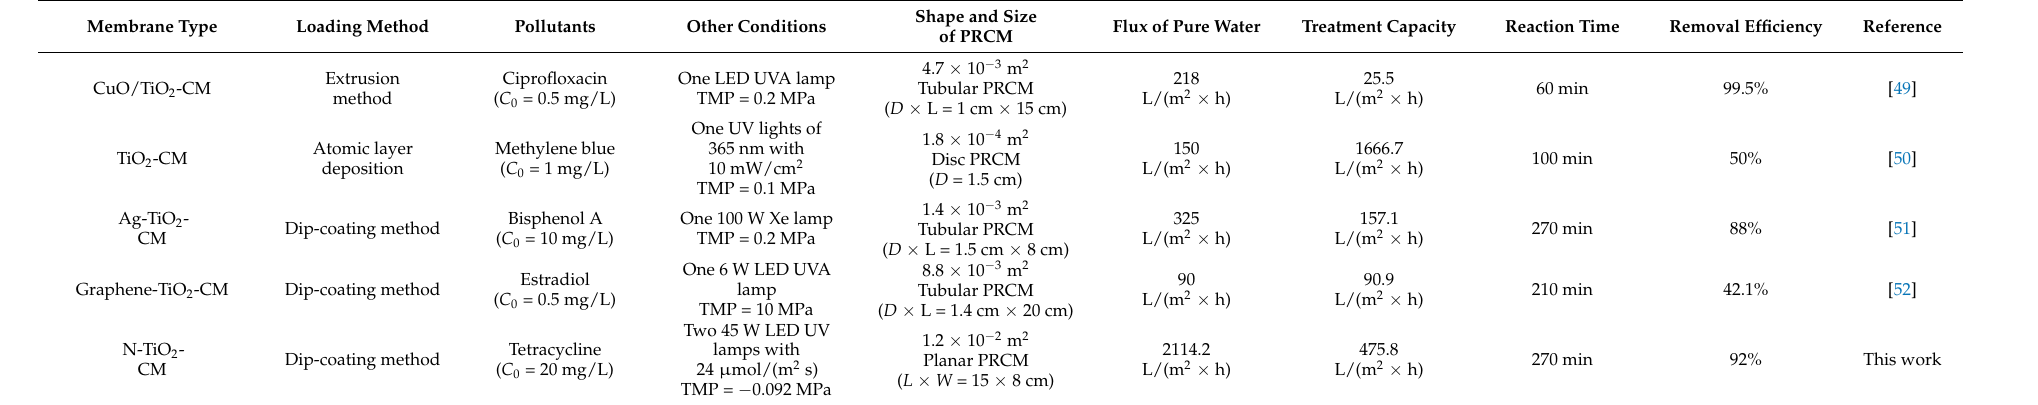
Table 1. Comprehensive comparison of pollutants treatment performance of the different PRCM.